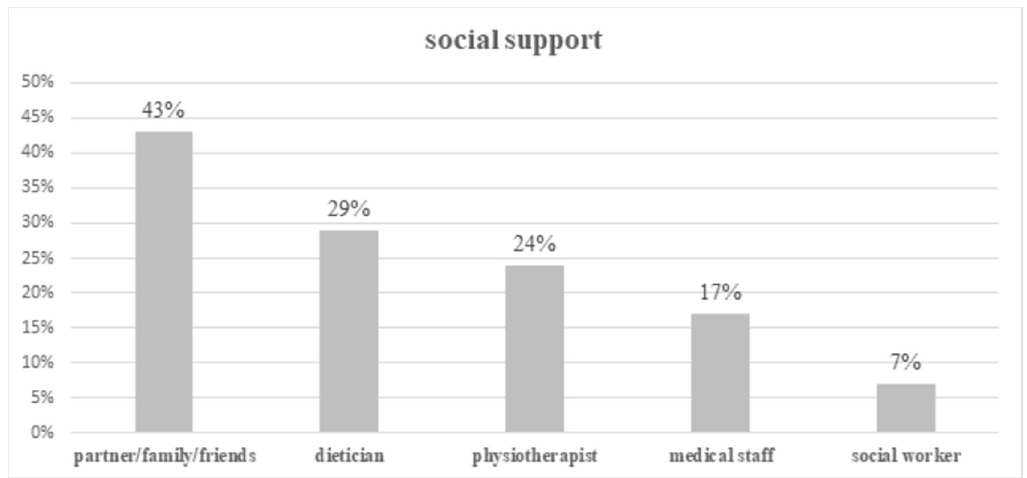
Figure 2. Social support for cancer patients (some patients received support from more than one helper).